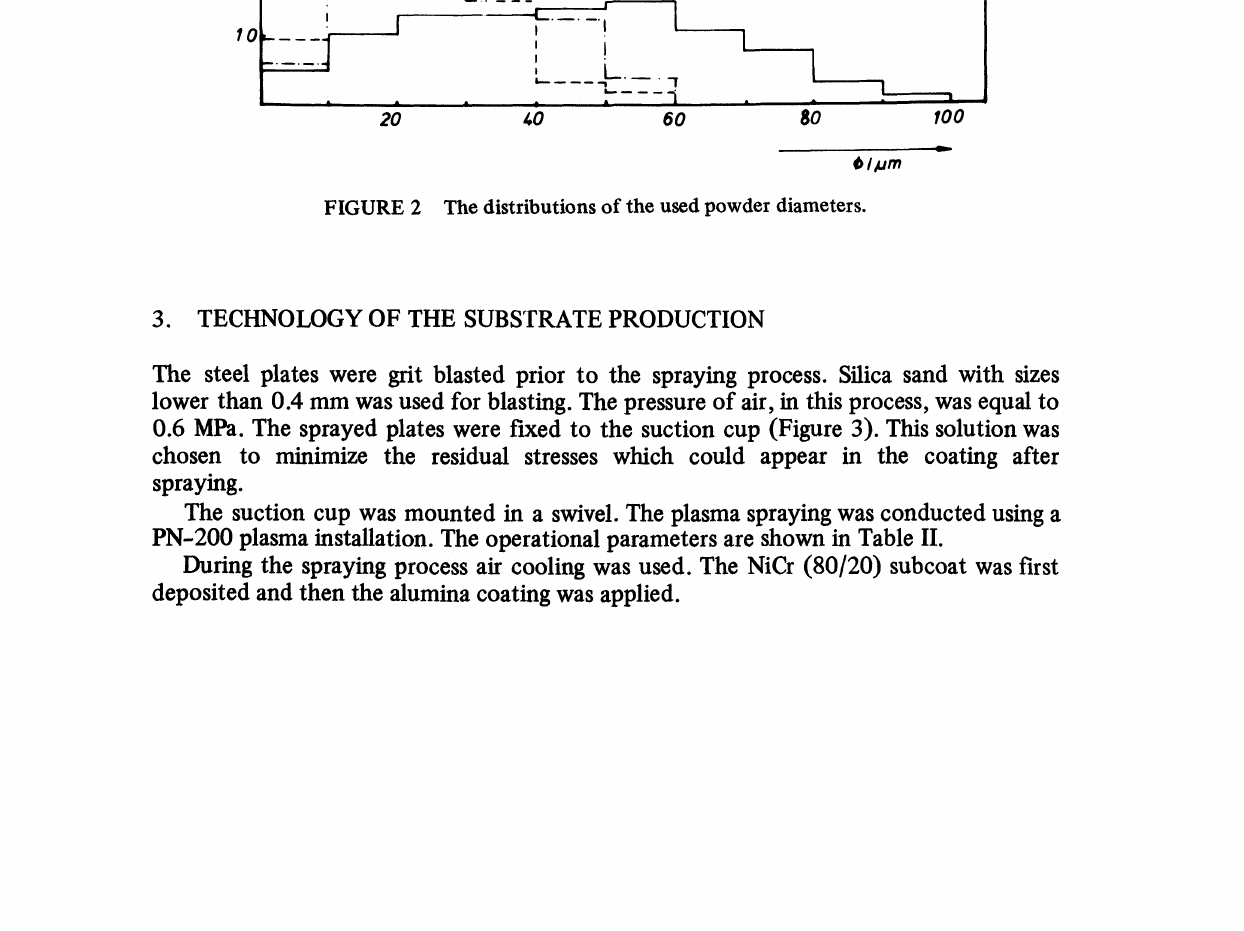
FIGURE 1 The shape of alumina powders used, a 01, b OD.